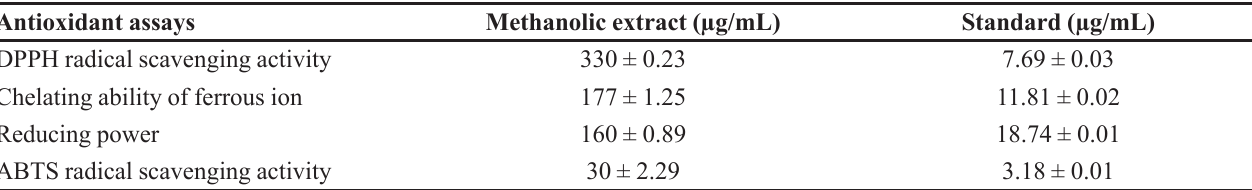
TABLE III - Antioxidant activity of methanolic fraction extracted from Lepista sordida . Results are expressed in EC50 values (mean ± standard deviations;